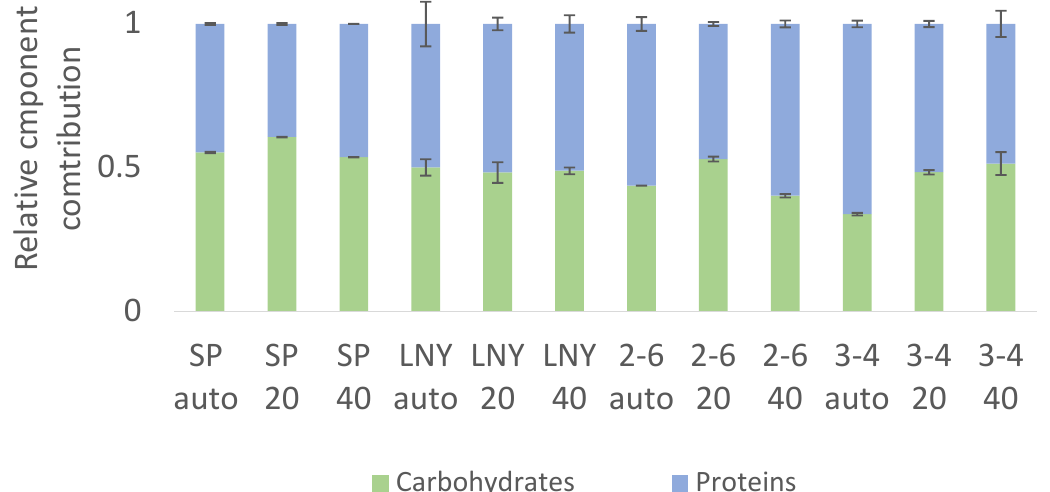
Figure 3. Biochemical composition (determined by FTIR) of algal strains grown under autotrophic conditions (auto), and heterotrophic conditions with 20 or 40 mM glycerol (designated 20 mM and 40 mM, respectively). Means ± SE, n = 3.